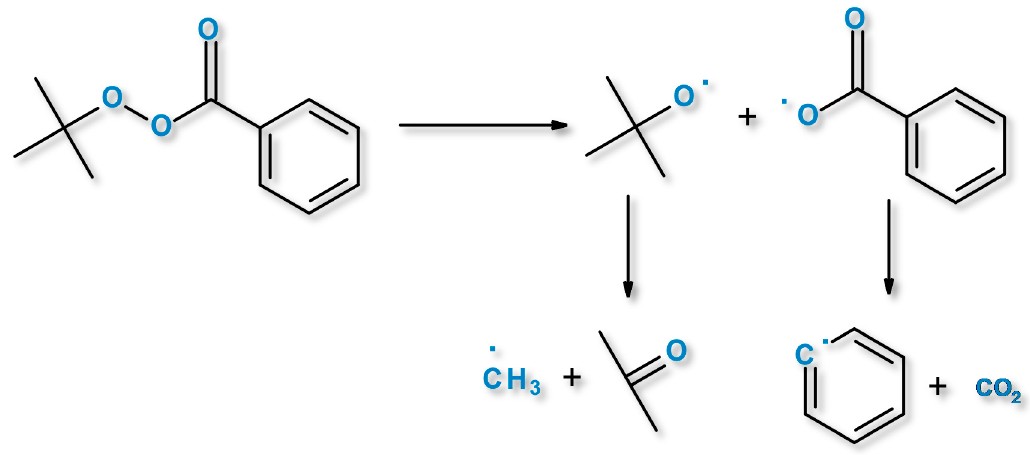
Figure 2. A scheme of the thermal decomposition mechanism of PB.